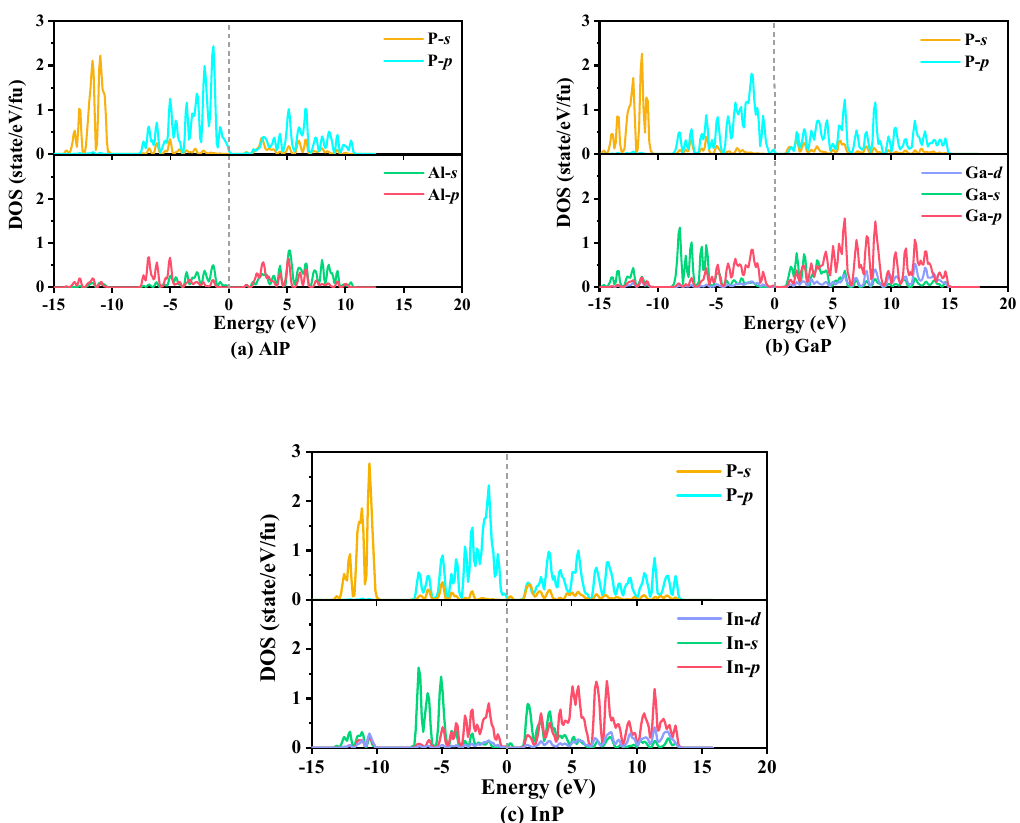
Figure 8. The partial densities of states of P 6 4 22- X P ( X = Al, Ga, or In): AlP ( a ), GaP ( b ), and InP ( c ).